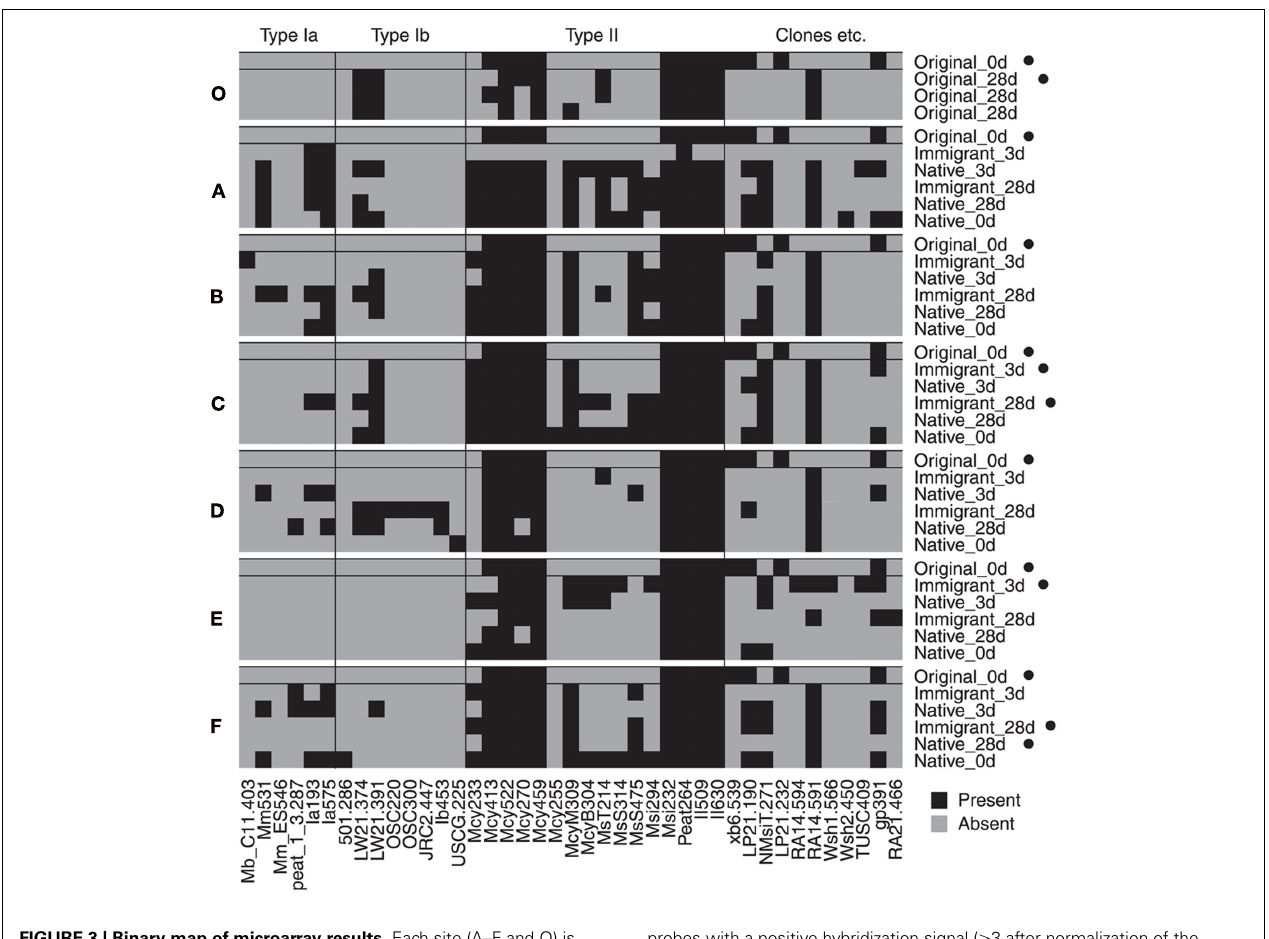
probes with a positive hybridization signal ( ≥ 3 after normalization of the data to the scale of 0–100) on any of the samples are shown (universal MOB probes were not included). Binary results were converted from the semiquantitative data presented as a heatmap in the FigureA2 in